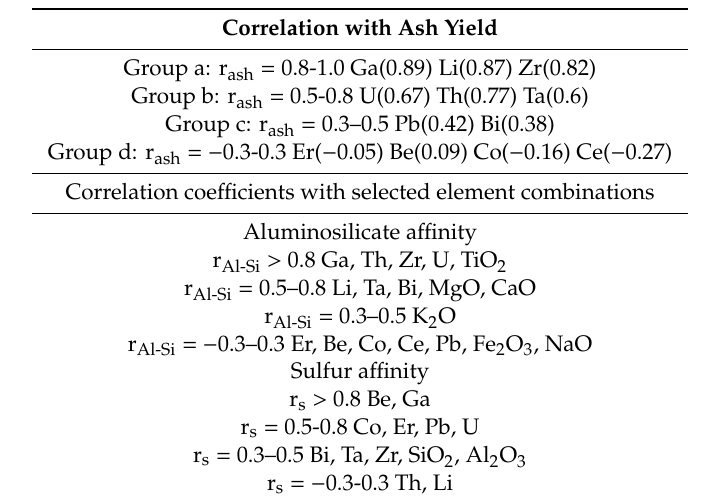
Table 6. Element a ffi nities between the concentration of elevated element in the coal and ash yield or selected elements.